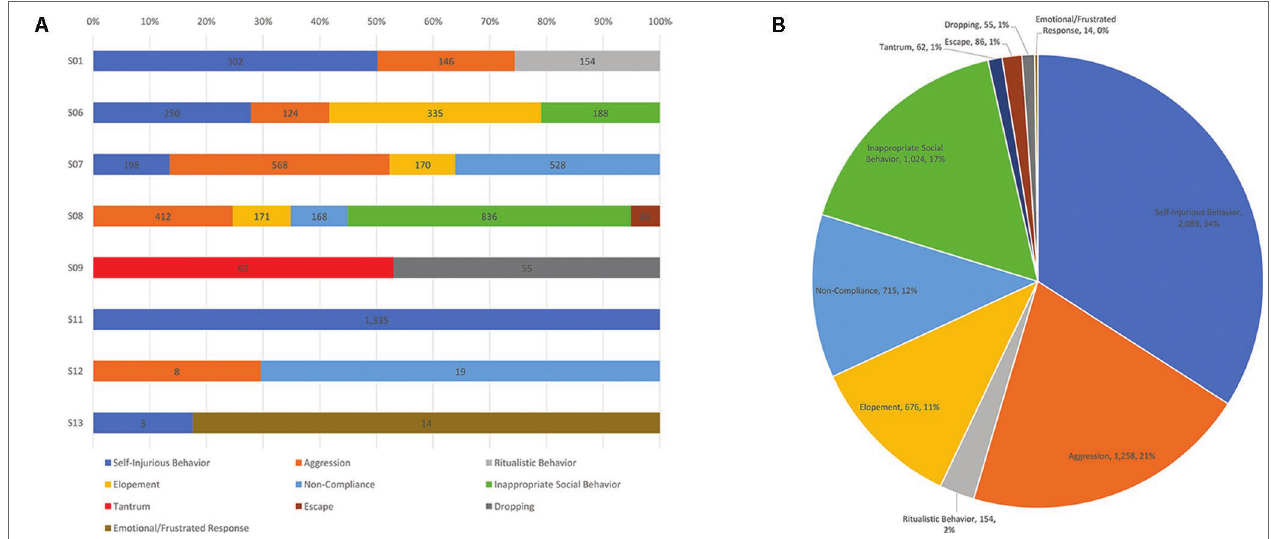
FIGURE 1 | (A) Frequency counts of the types of problem behaviors engaged in over 1 year for each student in the sample. (B) Total number of behaviors engaged in by the sample over 1 year and proportion of the whole that each behavior